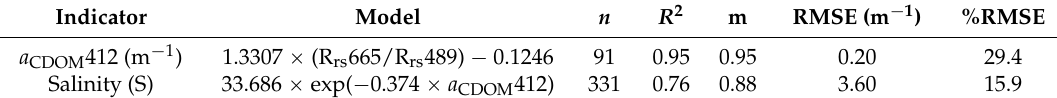
Table 3. Model II regression statistics from the validation of CDOM absorption and salinity values derived from the algorithms and field data from NB, NR, CB, SAB, SJB, PB, and NW Gulf of Mexico inner continental shelf waters. Please see Table 1 for estuary abbreviations. Shown are the units of measurement; the number of samples used ( n ) to validate the algorithm; goodness of fit ( R 2 ) of the relationship between measured and predicted values; the slope ( m ) of the line of measured and predicted values; and the root-mean-square error of measured and predicted values.